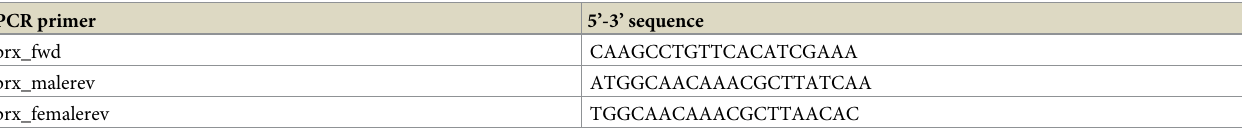
Table 1. Brx PCR